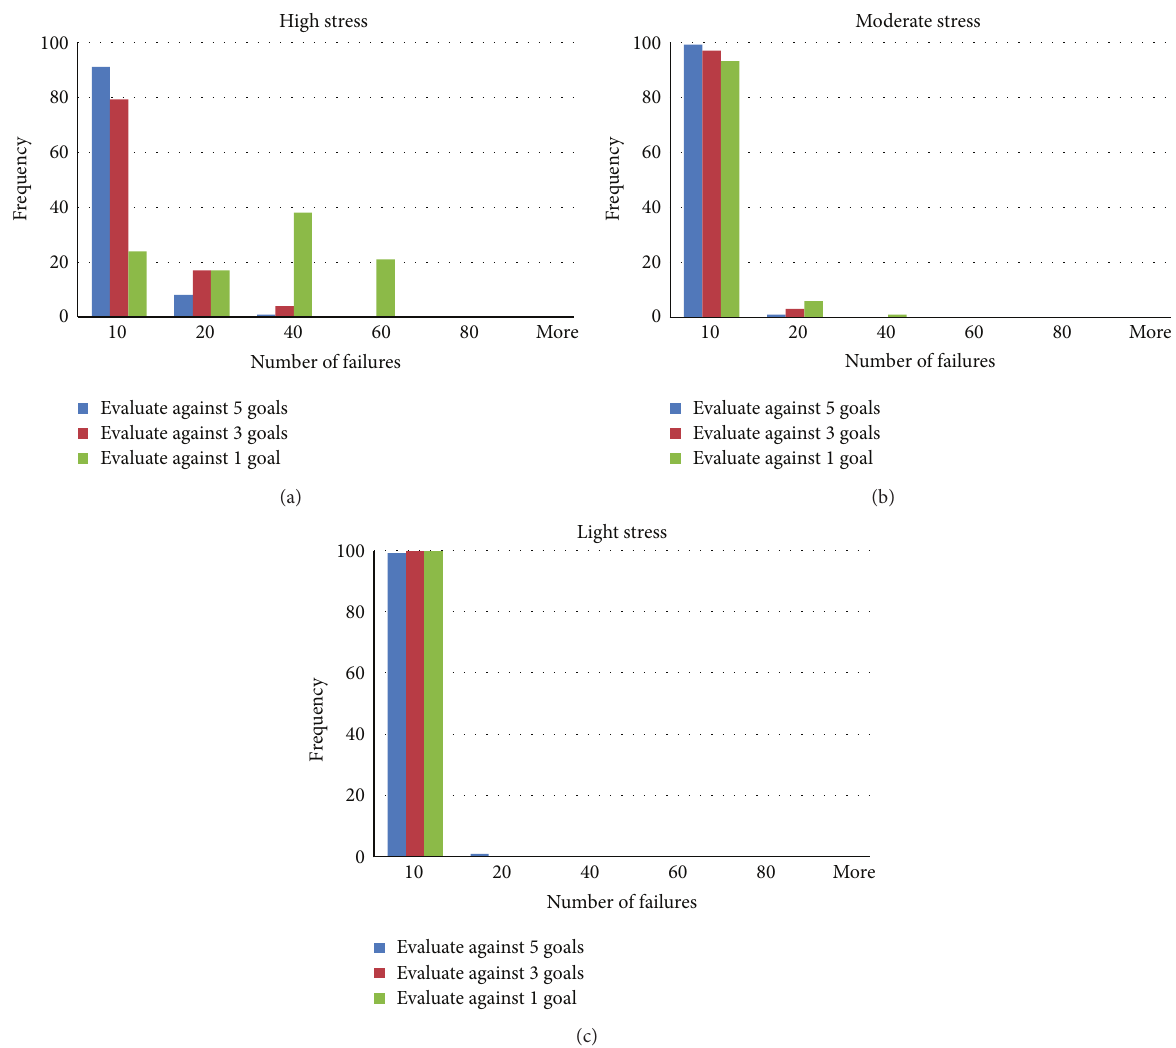
Figure 2: Number of failures during reappraisal for 50-50